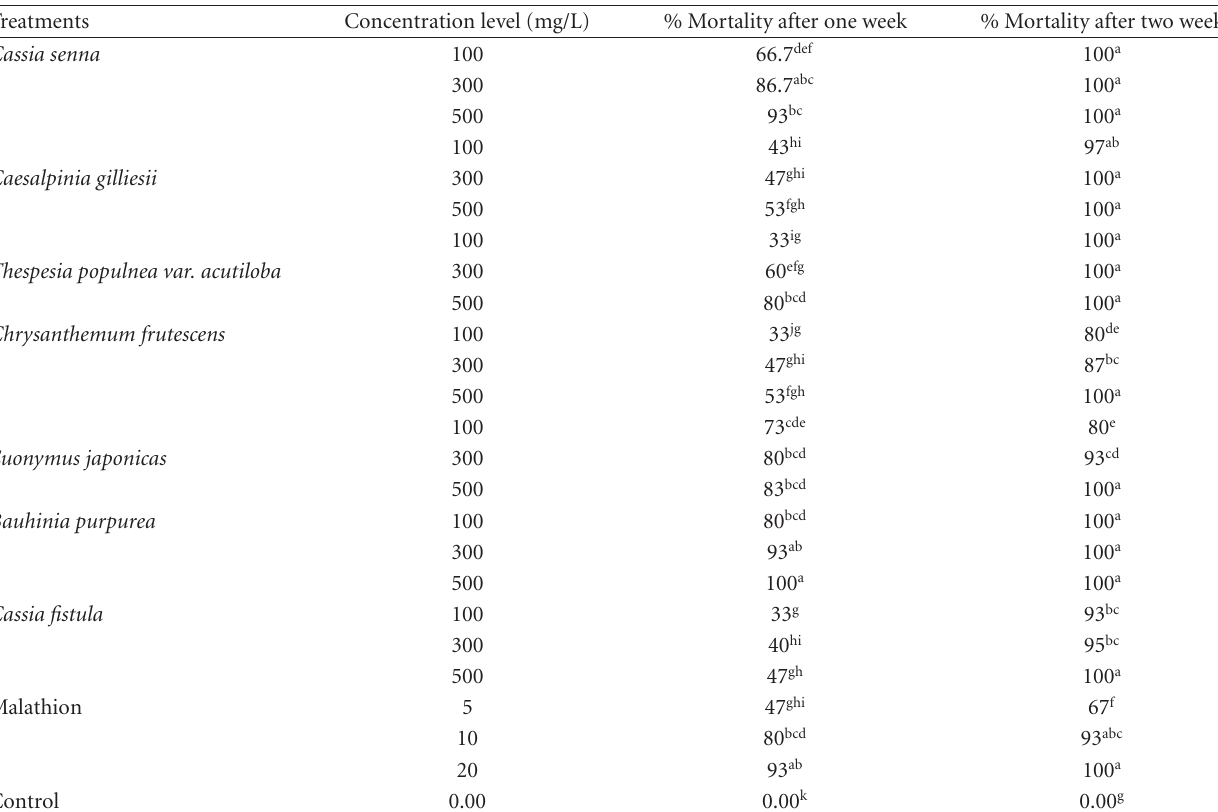
Table 3: E ff ect of the tested plant extracts and malathion on mortality of T. granarium pupae.